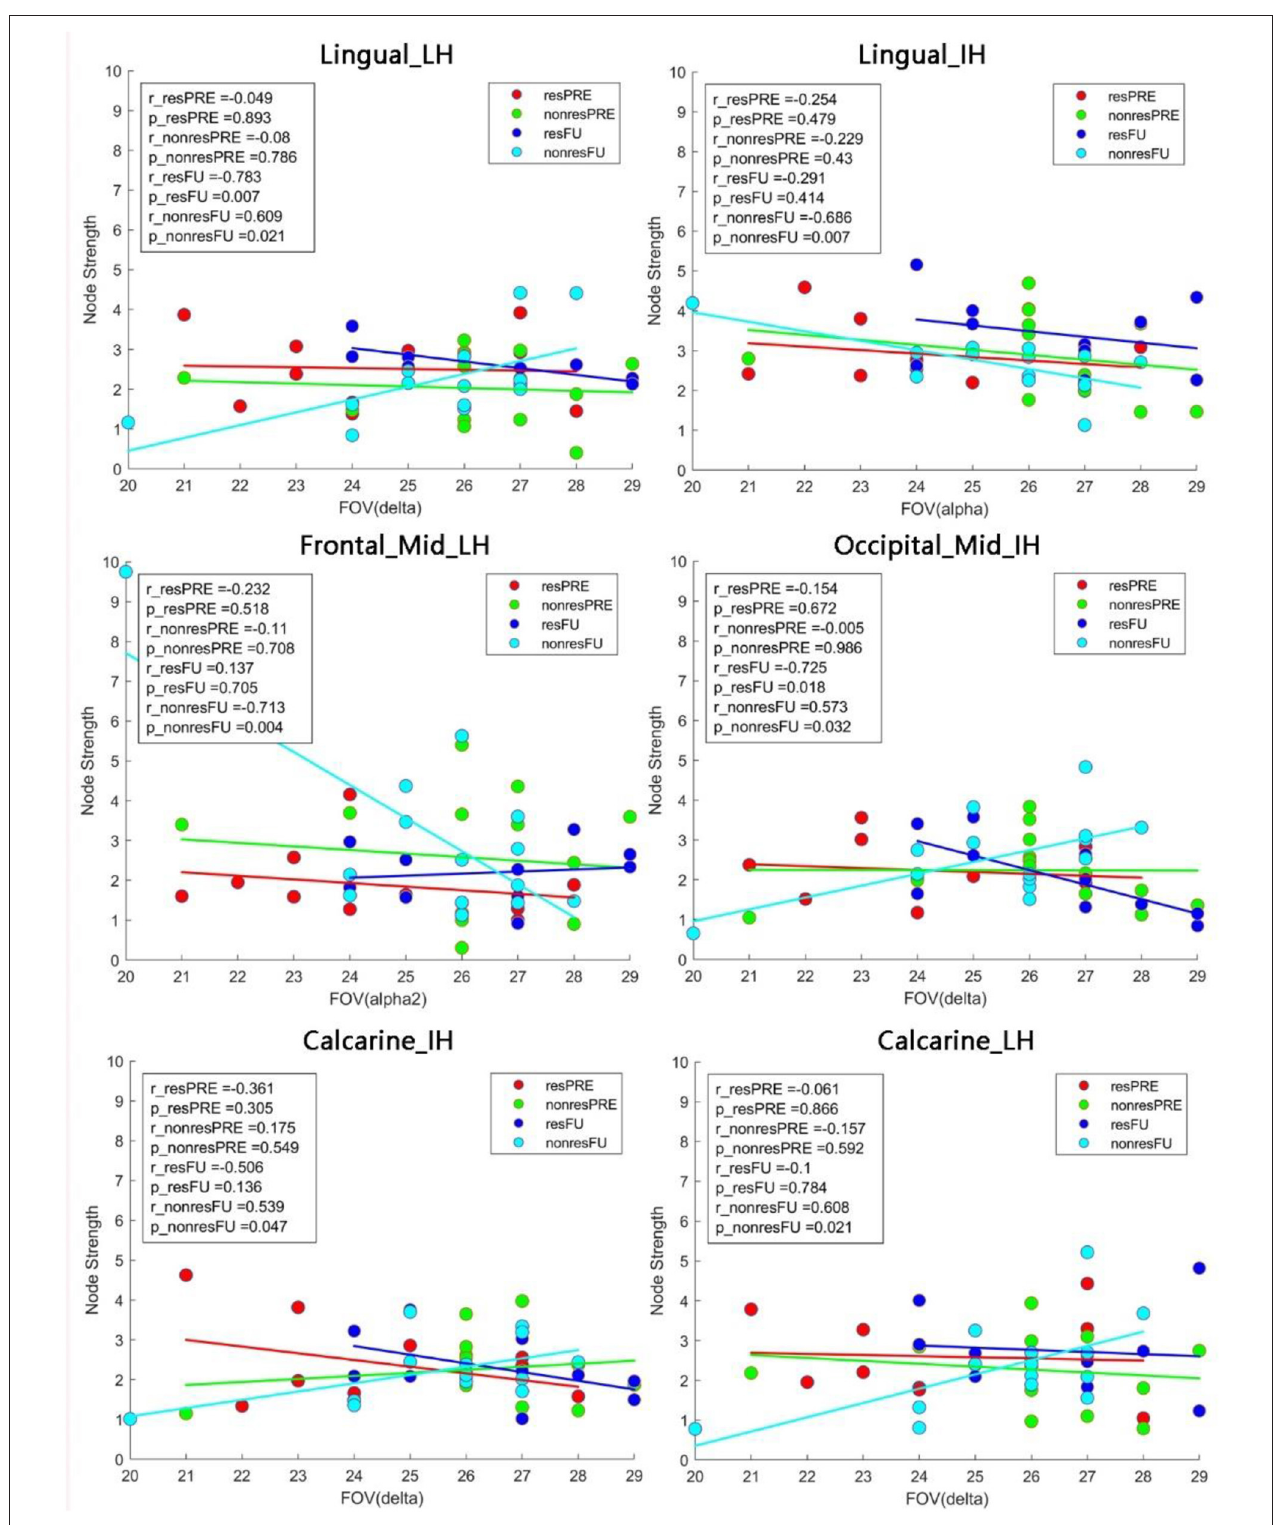
FIGURE 6 | Pearson correlation between the FOV and node strength. In non-responders, we observed a positive correlation between FOV and node strength in the lingual_LH and calcarine_LH in the delta band. In the alpha band, node strength of both the lingual_IH and middle frontal_LH was negatively correlated with FOV. resFU, responders at FU; nonresFU, non-responders at FU; resPRE, responders at baseline; nonresPRE, non-responders at baseline.